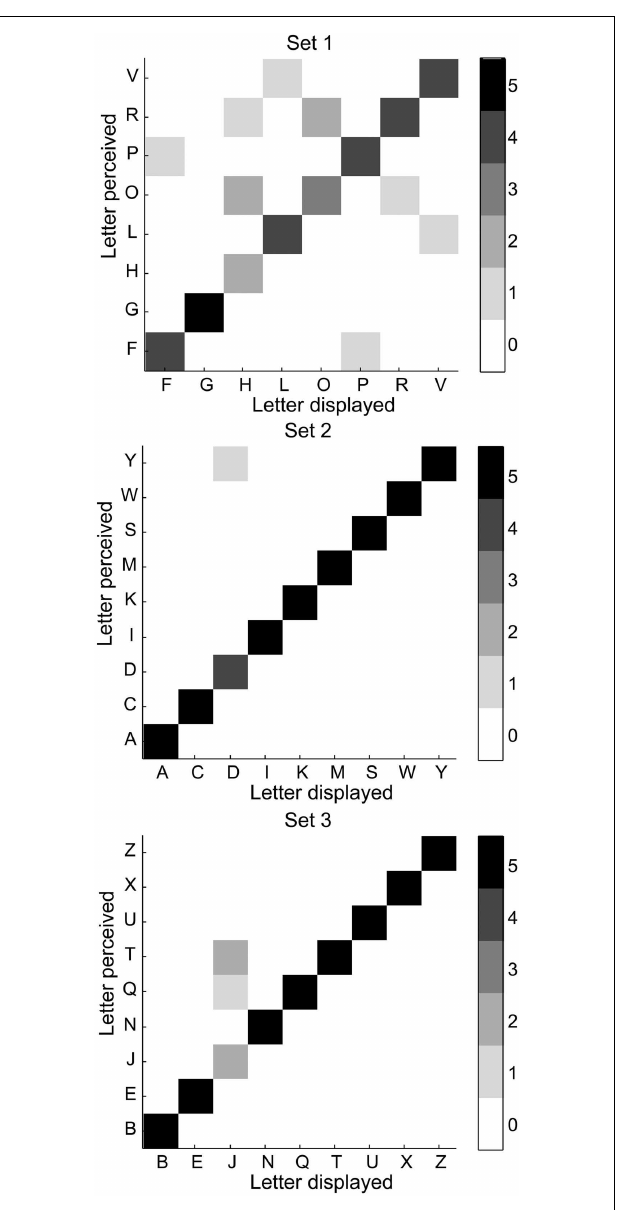
FIGURE 5 | Error matrices. Matrix plots of letter perceived ( y -axis) as a function of the letter displayed ( x -axis).The ideal case would be a diagonal matrix.